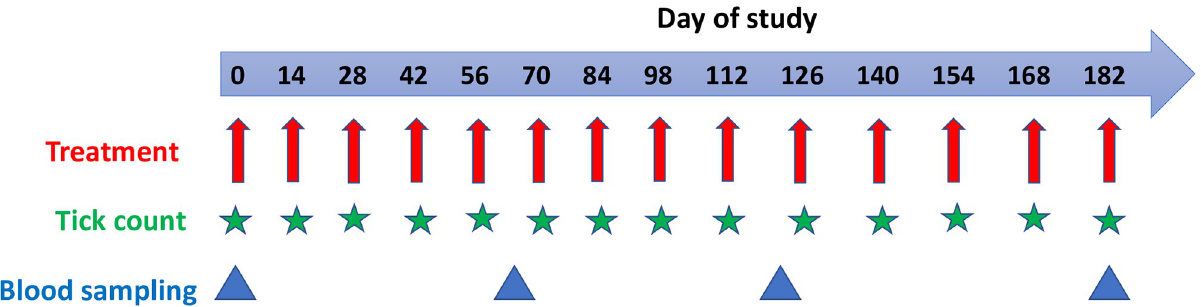
Fig 3. Design of the treatment regime. Administration of treatments (red arrows), time-points of tick counting (green stars) and time-points for serum and whole blood sampling (blue triangles).